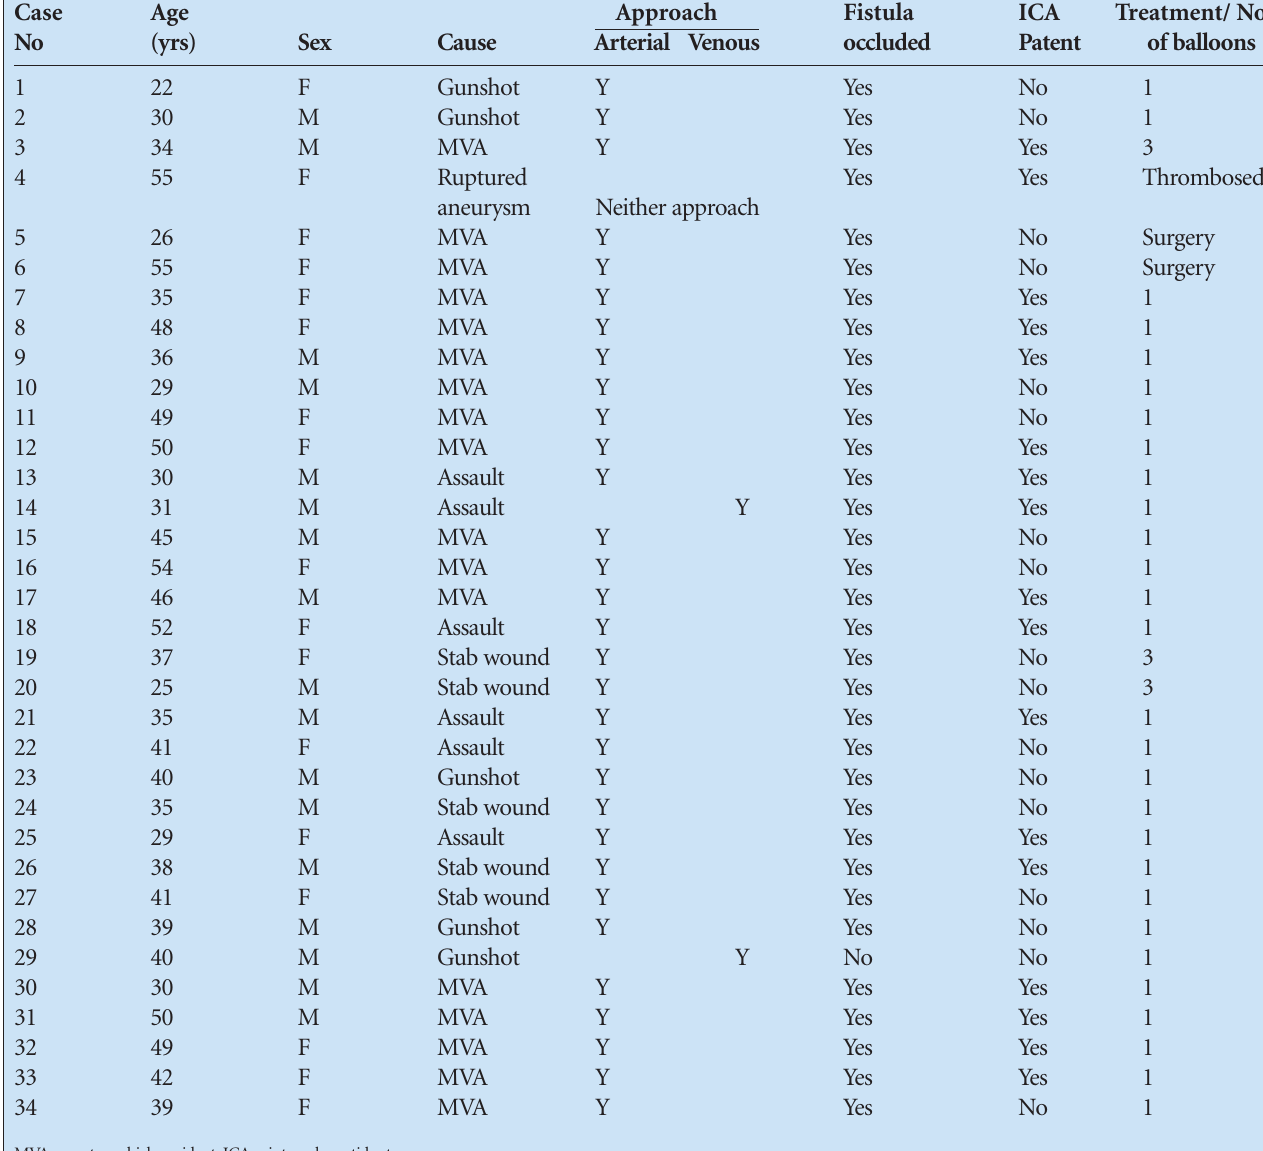
Table III.Summary of 34 patients with carotid-cavernous fistulae (in chronological order)